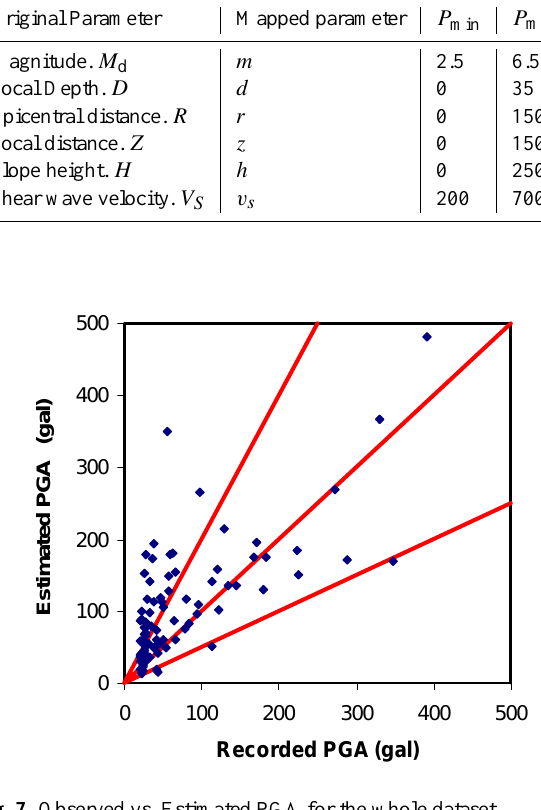
Fig. 7. Observed vs. Estimated PGA for the whole dataset. Figure 7. Observed vs. Estimated PGA for the whole dataset